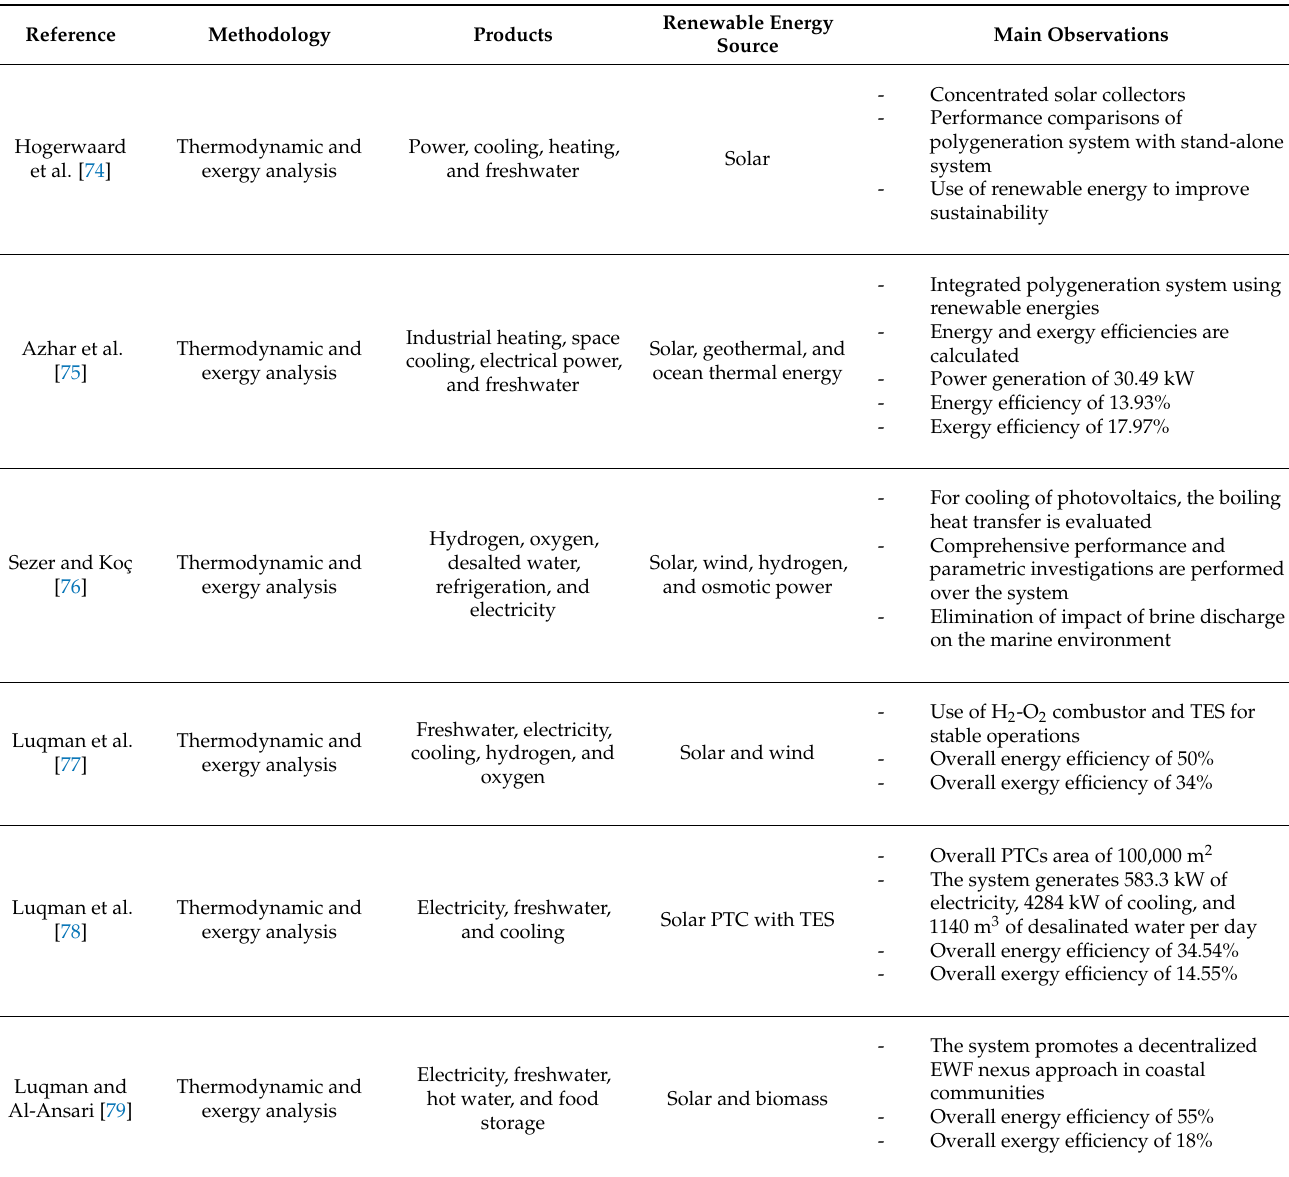
Table 1. Summary of topical research on integrated renewable energy-driven polygeneration and MSF desalination systems.